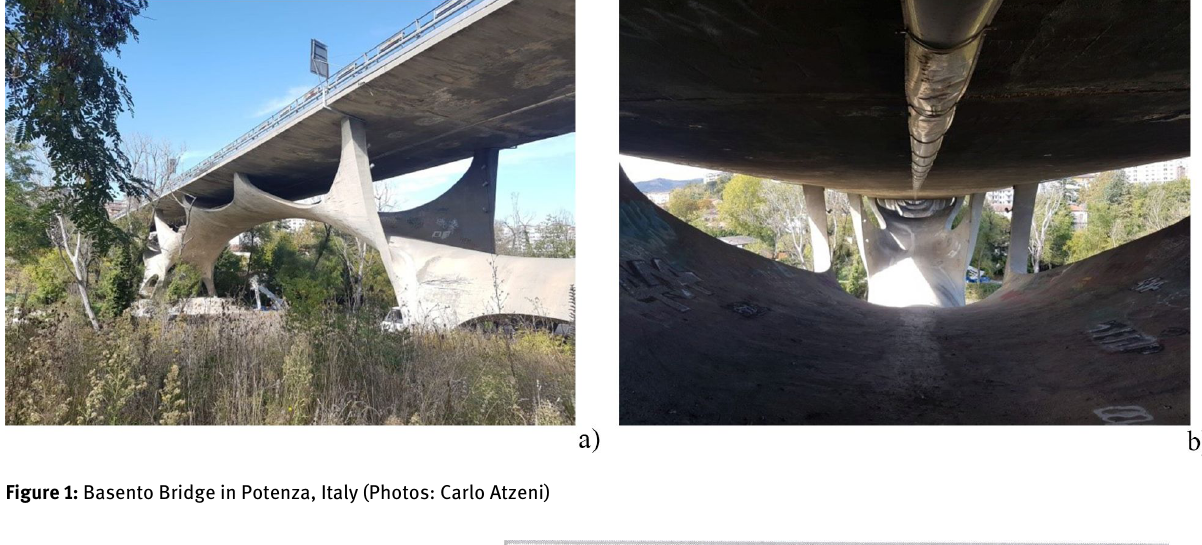
Figure 1: Basento Bridge in Potenza, Italy (Photos: Carlo Atzeni)